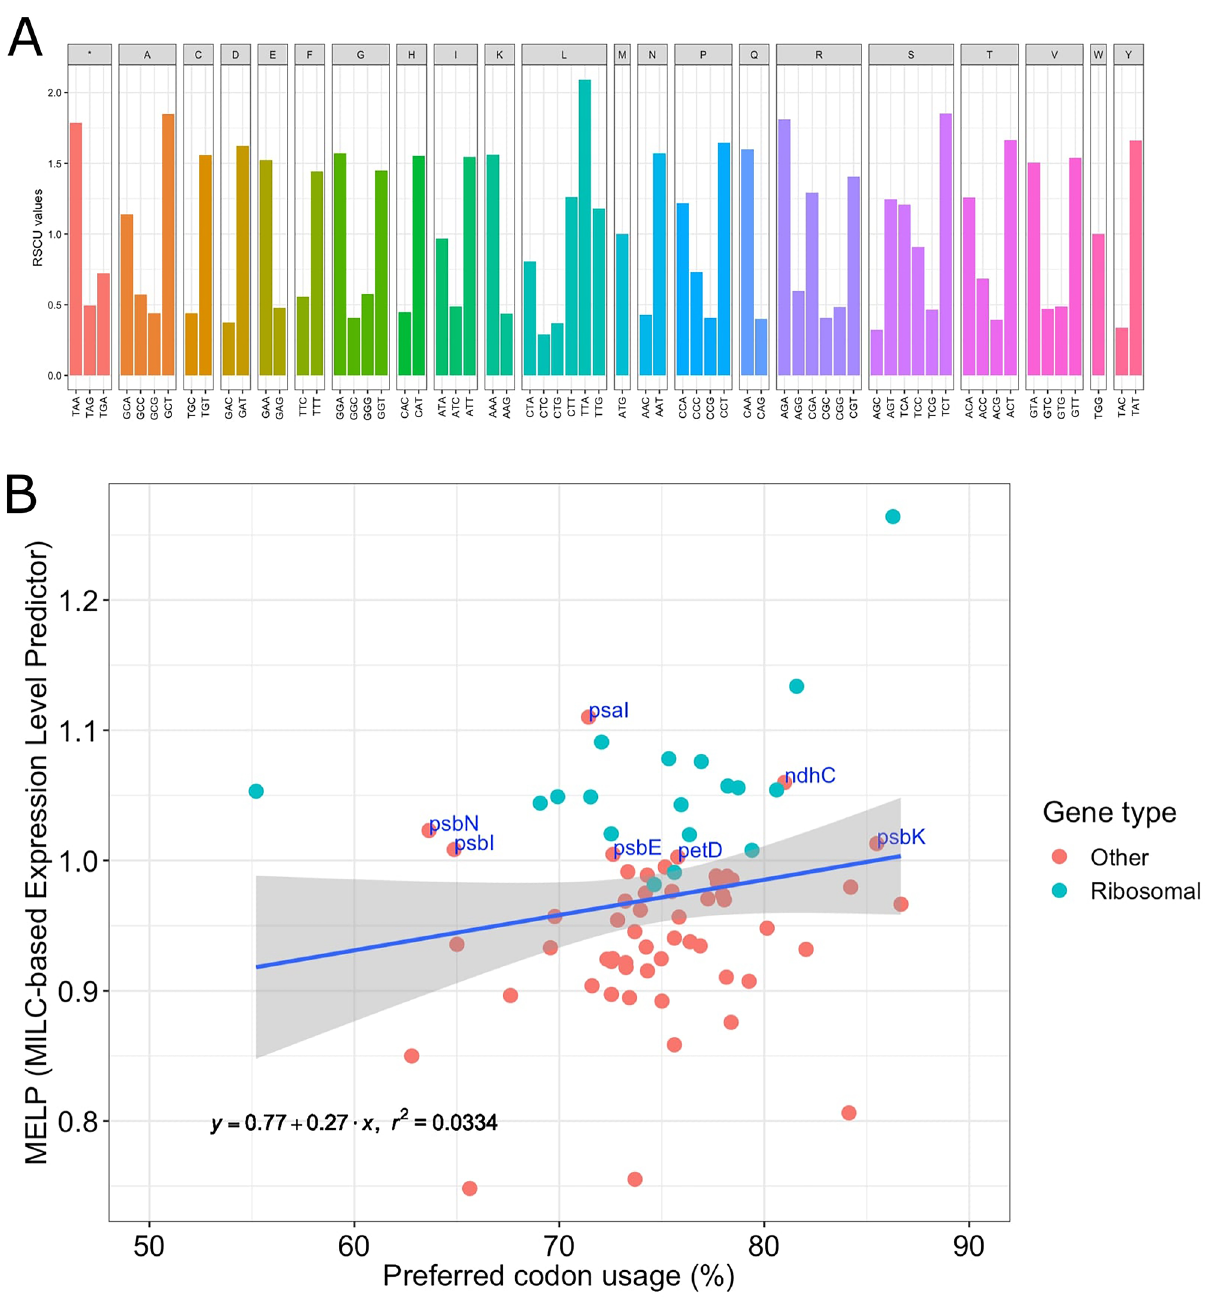
and their MELP index. Ribosomal genes are in green and other genes are read. Only non-ribosomal genes with MELP > 1.0 are labelled with gene names. Blue line represents the linear regression and the grey area surrounding the line shows the confidence